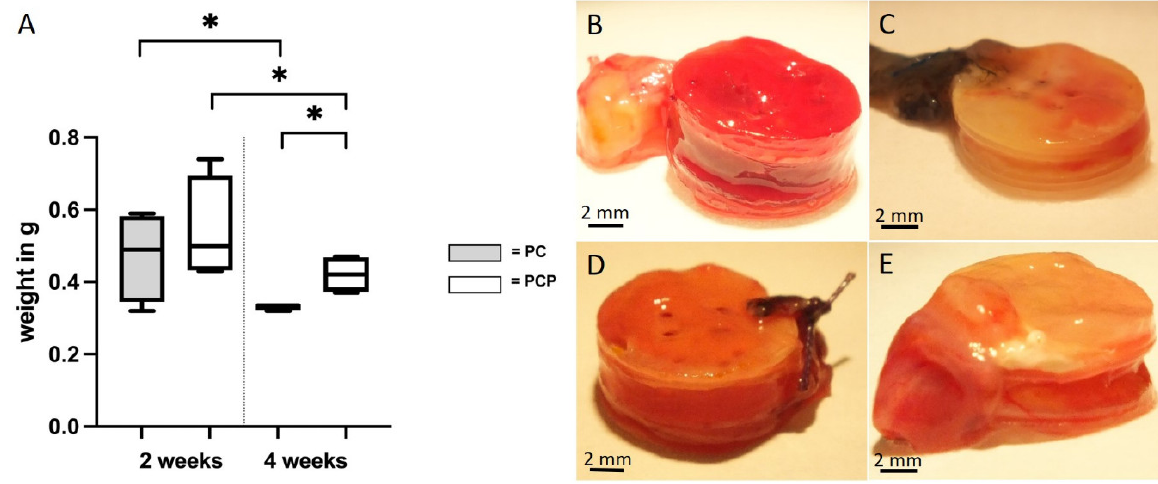
Figure 4. Explanted scaffold-EPI loop-constructs. ( A ): Explant weights. Box plots demonstrate decrease from two weeks to four weeks of implantation and differences of PC and PCP after four weeks of implantation (* p ≤ 0.05, unpaired t -test); ( B ): PCL-collagen I-scaffold-construct after two weeks of implantation ( C ): PCL-collagen I-scaffold-construct after four weeks of implantation ( D ): PCL-collagen I-PEO-scaffold-construct after two weeks of implantation ( E ): PCL-collagen I-PEO-scaffold-construct after four weeks of